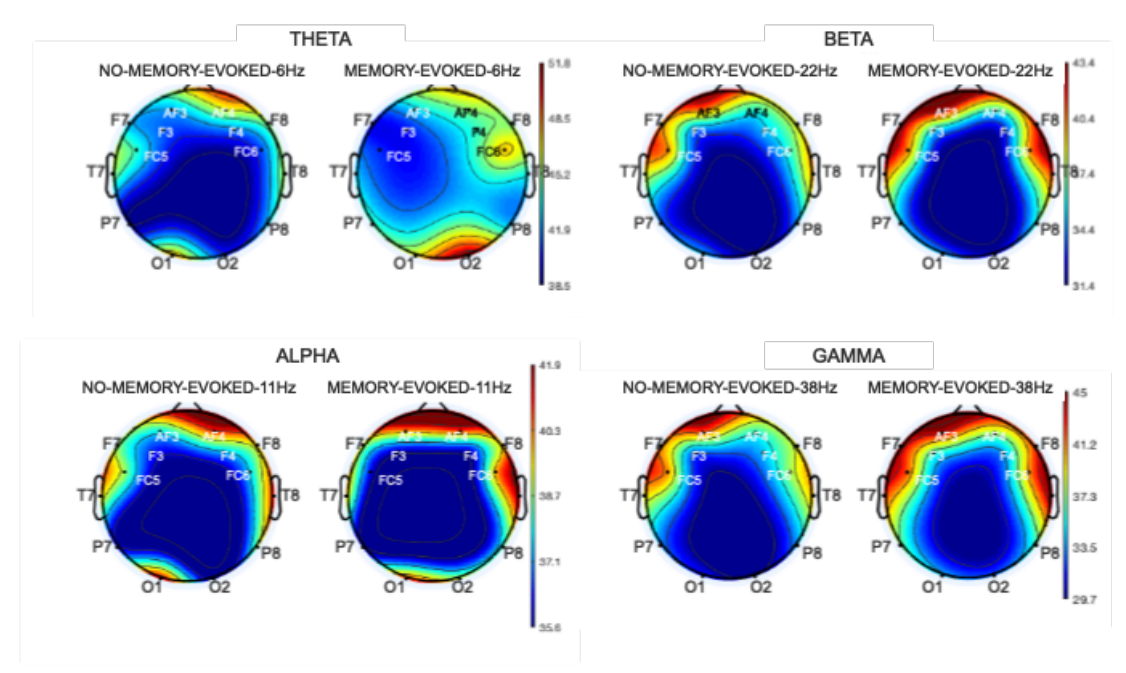
Figure 6. Spectral power map for participant P 2. For each frequency band: left, “NO-MEMORY- EVOKED”; right, “MEMORY-EVOKED”.